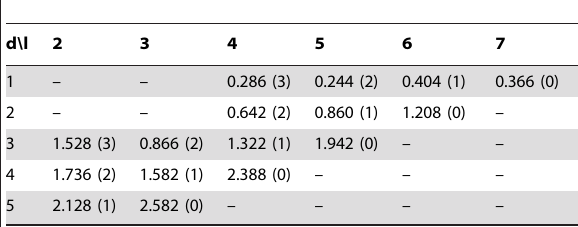
Table 4. Data without GC content.